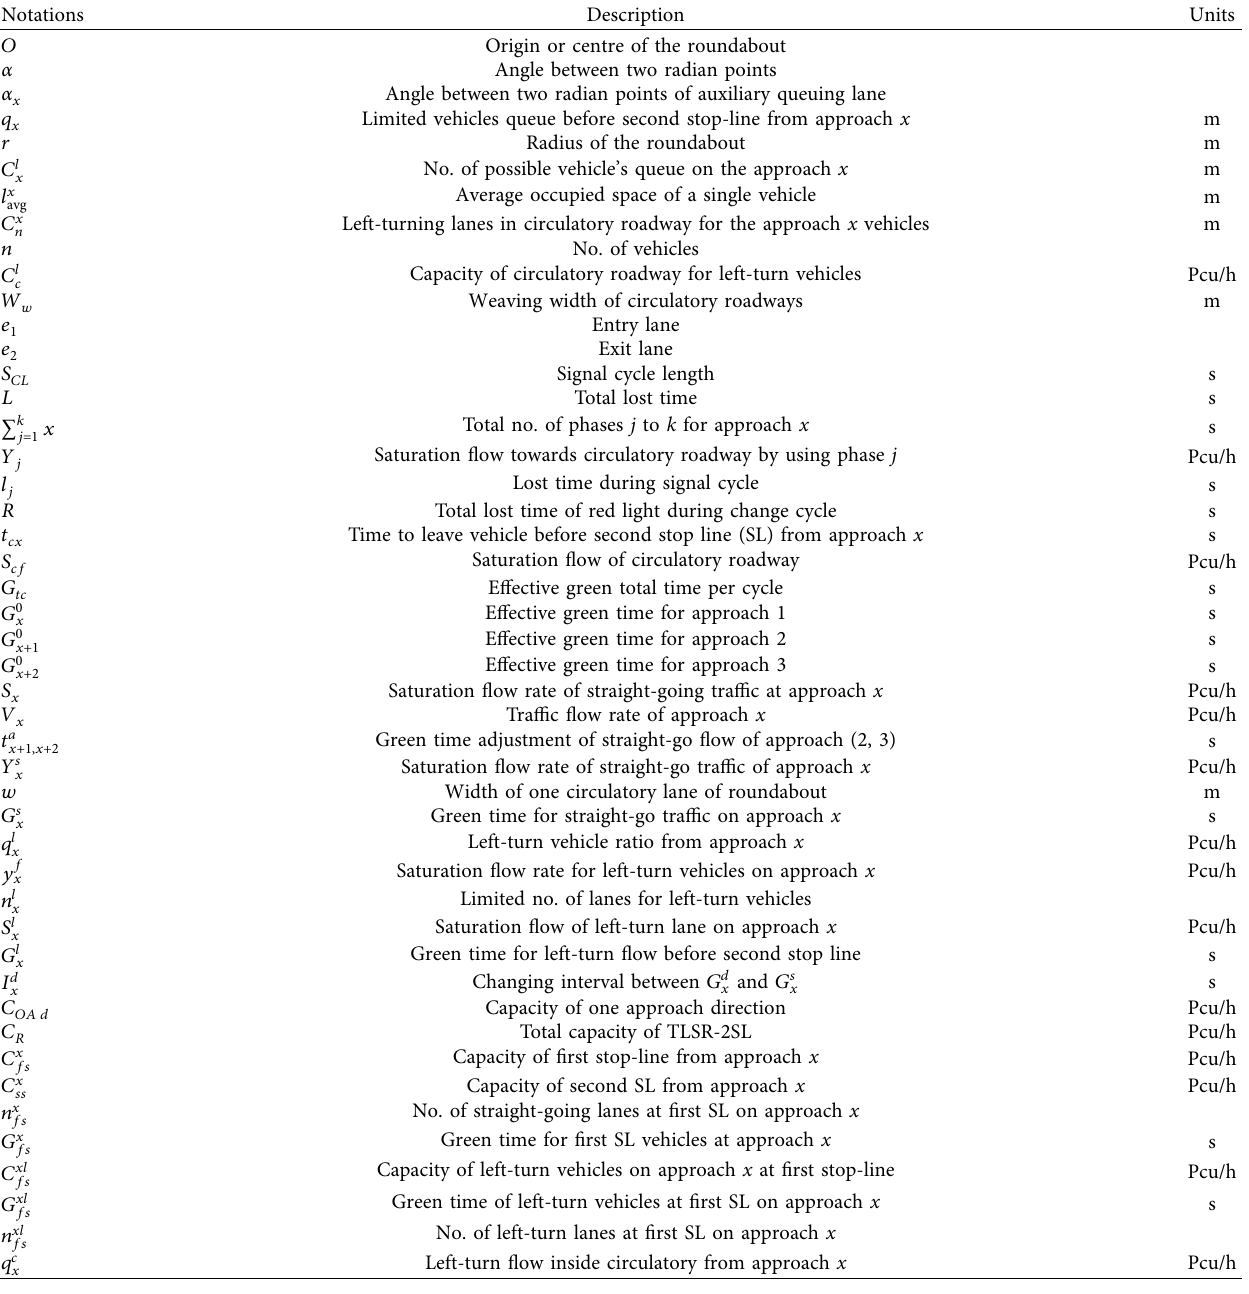
Table 1: Notations’ variables used in this